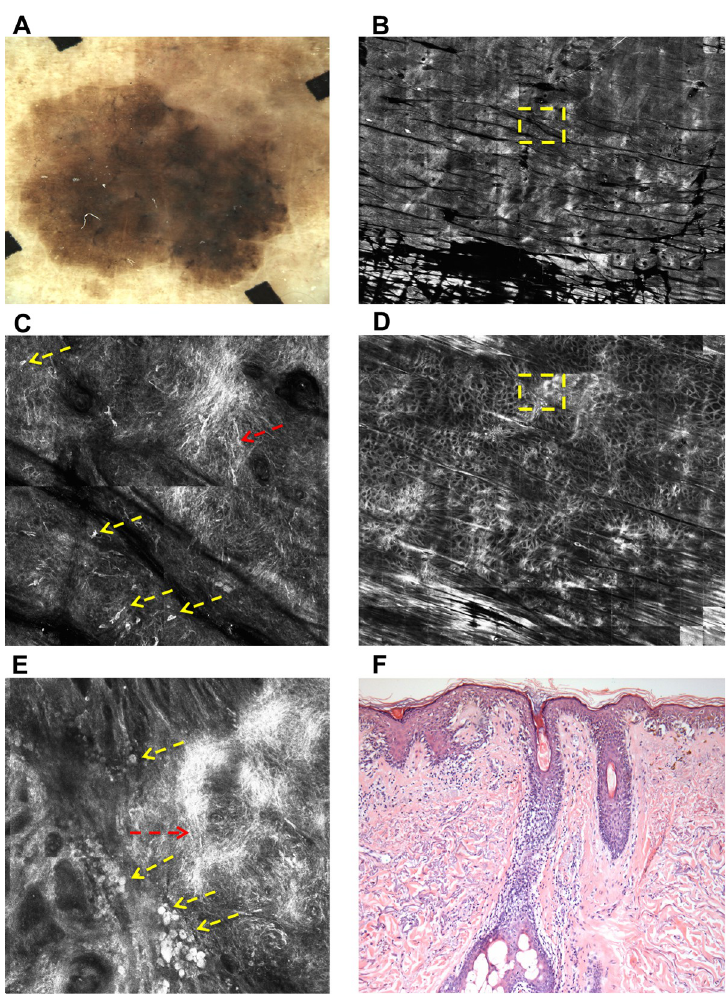
Fig 1. Superficial spreading melanoma in situ . (A): Dermoscopy shows atypical network and peppering. (B): RCM mosaic image (8.0 x 8.0 mm) at the spinous layer; visual inspection positioned the hotspot at a central location (1.0 x 1.0 mm square area is marked with yellow dashed outline and better shown in C). (C): Atypical honeycomb pattern and widespread roundish cells (yellow arrows) and dendritic cells (red arrows) in sheet of cells distribution. (D): RCM mosaic image (8.0 X 8.0 mm) at DEJ; visual inspection positioned the hotspot at a peripheral location (1.0 x 1.0 mm square area is marked with yellow dashed outline and better shown in E). (E): Non-edged papillae, roundish cells at DEJ (yellow arrows) and dendritic cells (red arrows) in sheet of cells distribution. (F): Histopathology confirms a superficial spreading melanoma in situ (H&E, original magnification x200), with disarrangement of the rete ridge and increased number of atypical melanocytes affecting the